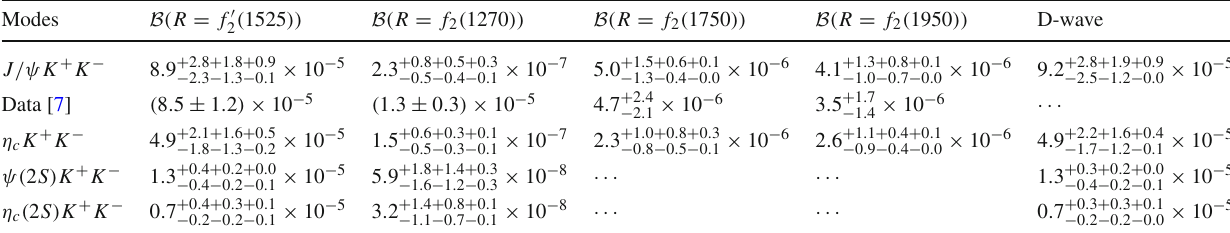
Table 4 Branching ratios of D -wave resonant contributions to the B s → ( J /ψ,ψ( 2 S ),η c ,η c ( 2 S )) K + K − decays. For theoretical errors, see Table 3. The statistical and systematic uncertainties from [7] are combined in quadrature